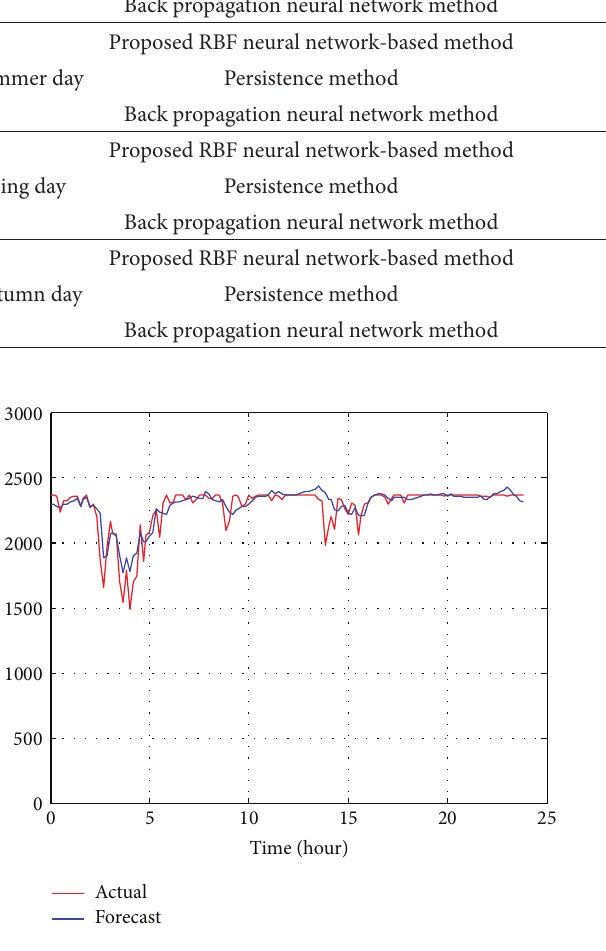
Figure 4: Numerical results with the RBF neural network-based method for typical winter day.